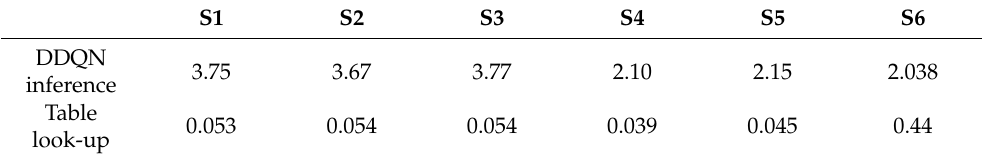
Table 11. Inference time of the DDQN simulation and table look-up method in each scenario.